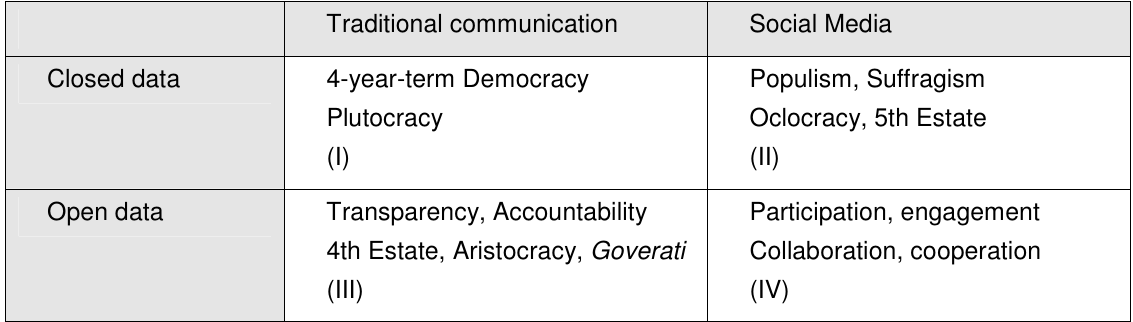
Table 2: Spaces of Open Data and Social Media